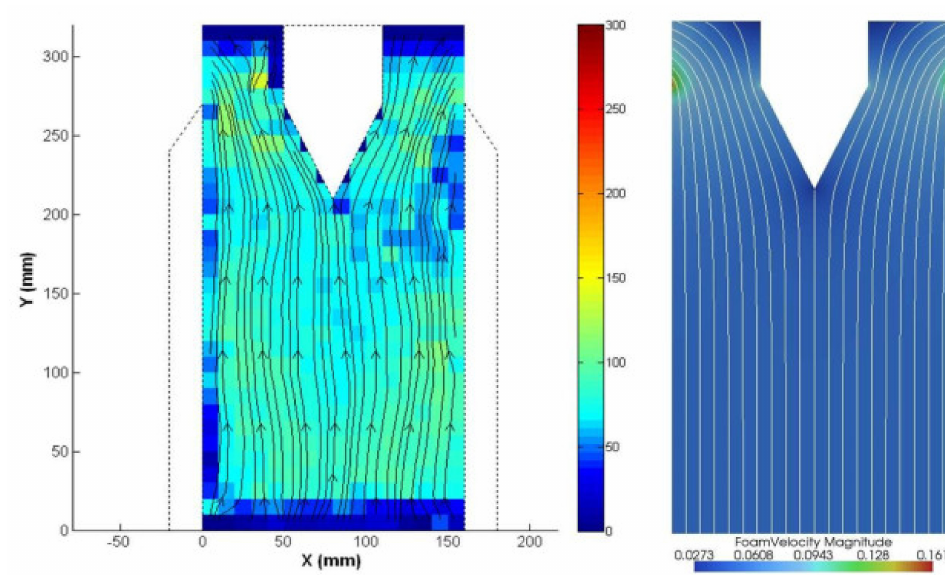
Figure 18. Bubble streamlines from an inverted triangular-shaped crowder